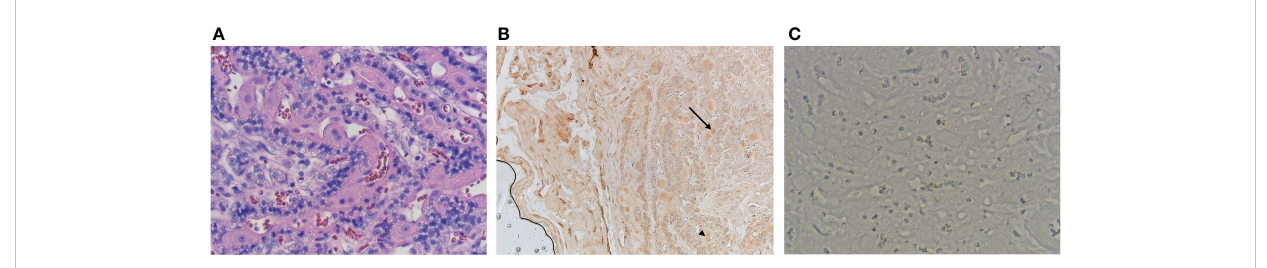
FIGURE 4 CRH localization in the labyrinth layer of a zonary section of the feline placenta. H&E staining of the labyrinth layer of post-partum placental tissue ( A ). Staining for CRH is observed in fetal trophoblast cells (arrow), including binucleate cells ( B ; arrowhead). No staining is observed when the primary antibody is omitted ( C ). Images were taken at